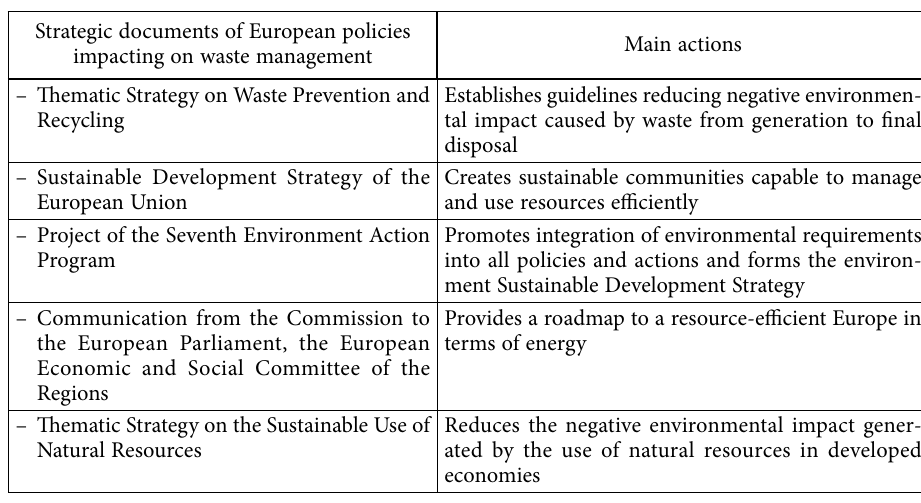
Table 1. Strategic documents of European policies impacting on waste management and their main actions (source: elaborated based on European Commission,